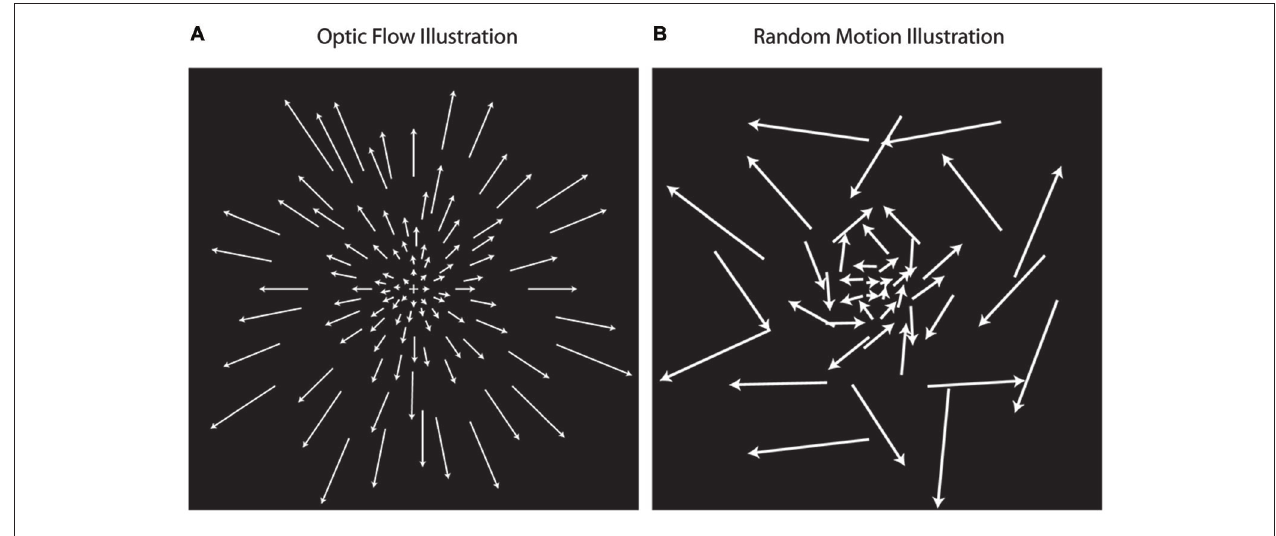
same speeds used in optic flow, but with random directions of movement. In the illustrations, the length of arrows corresponds with dot speed, indication that dot speed increases with distance away from the